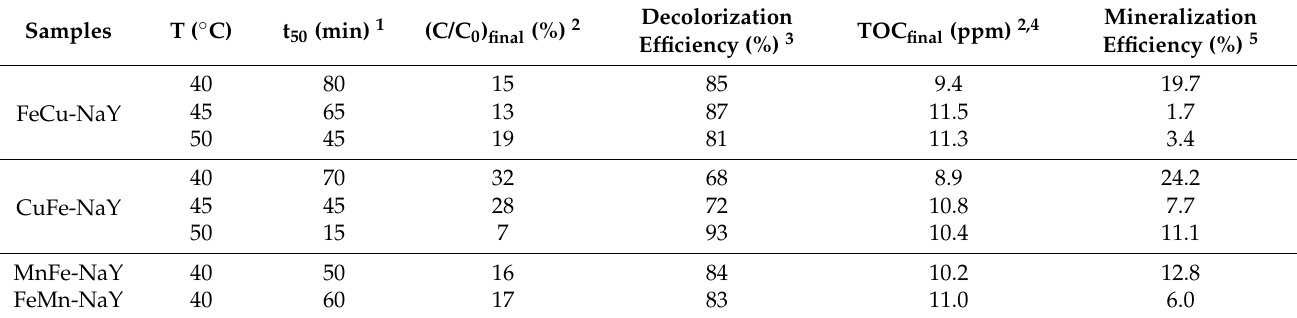
Table 3. Catalytic results for PY degradation on the bimetallic catalysts. Reaction conditions: 50 mg of catalyst, V PY = 250